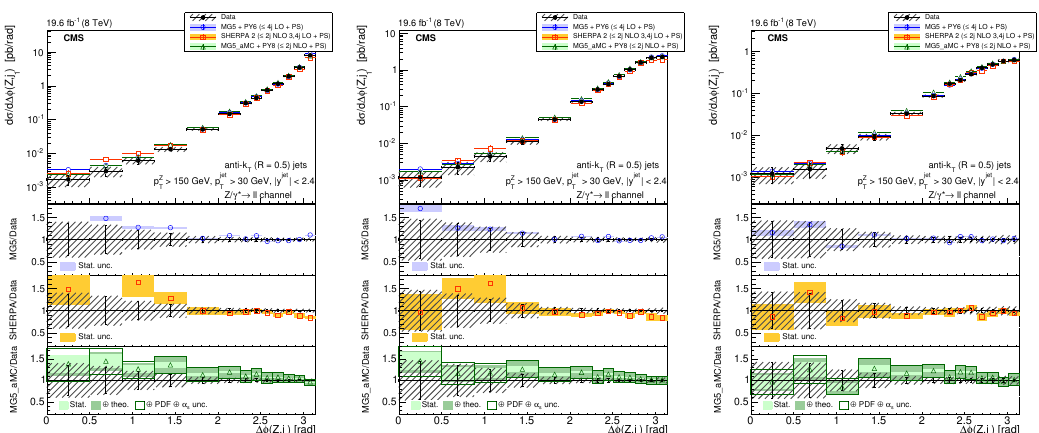
Figure 20 . The di(cid:11)erential cross section as a function of the azimuthal angle between the Z boson and the leading jet, for p T (Z) > 150 GeV and (left) N jets (cid:21) 1, (middle) N jets (cid:21) 2, and (right) N jets (cid:21) 3. The lower panels show the ratios of the theoretical predictions to the measurements. Error bars around the experimental points show the statistical uncertainty, while the cross-hatched bands indicate the statistical and systematic uncertainties added in quadrature. The boxes around the mg5 a mc + pythia 8 to measurement ratio represent the uncertainty on the prediction, in- cluding statistical, theoretical (from scale variations), and PDF uncertainties. The dark green area represents the statistical and theoretical uncertainties only, while the light green area represents the statistical uncertainty